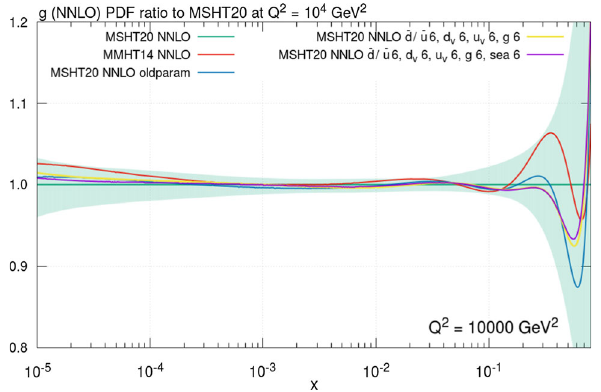
Fig. 45 Ratio of the down valence PDF to the MSHT20 default at Q 2 = 10 4 GeV 2 at NNLO showing how incrementing the old parame- terisation to the new parameterisation affects the PDFs produced tively. For the gluon it is clear that the differences that arise are well within the error bands and are also confined to the high x region where there are fewer constraints.